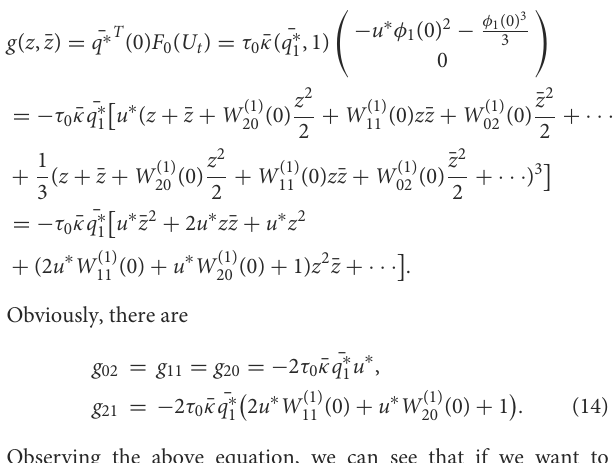
3 E β and y and the corresponding pattern when a +